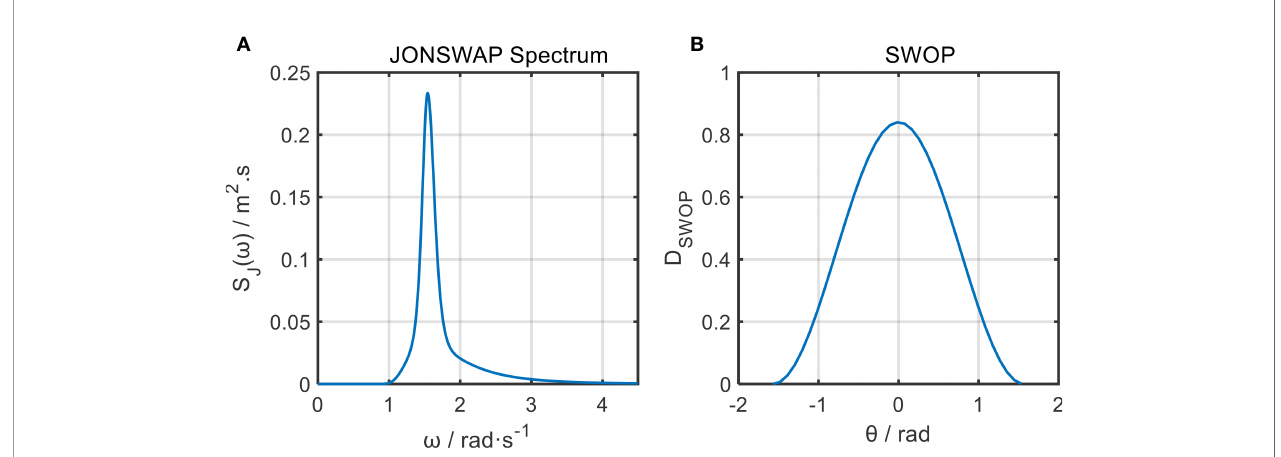
FIGURE 2 | U 10 = 7m/s (A) JONSWAP spectrum for g = 7; (B) SWOP directional extension function.